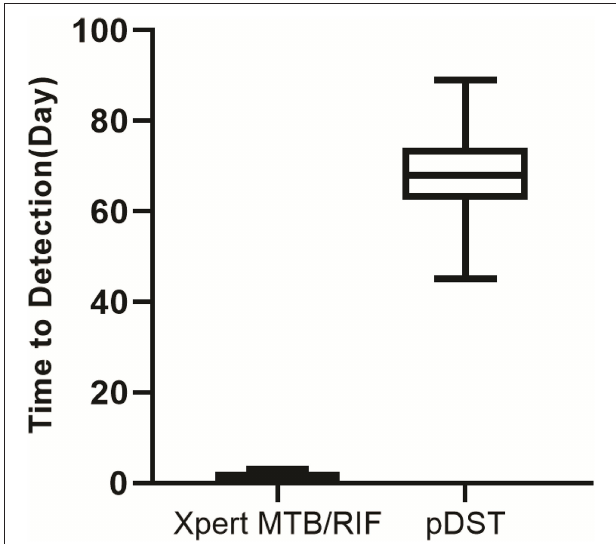
FIGURE 3 | Comparative analysis of turnaround time between Xpert Myobacterium tuberculosis (MTB)/RIF and phenotypical drug susceptibility testing (DST) in 2017. pDST, phenotypical drug susceptibility